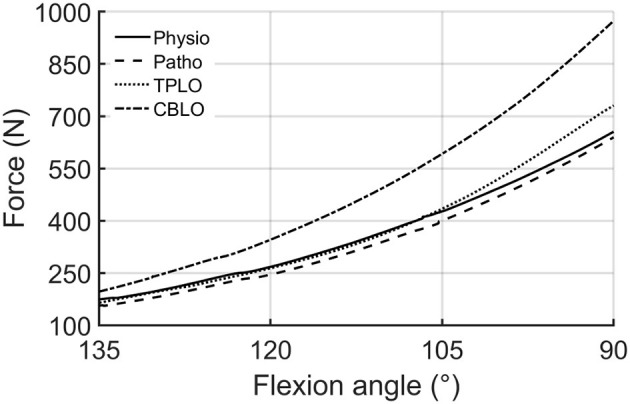
Quadriceps force generated through the PID controller during the squat simulation.